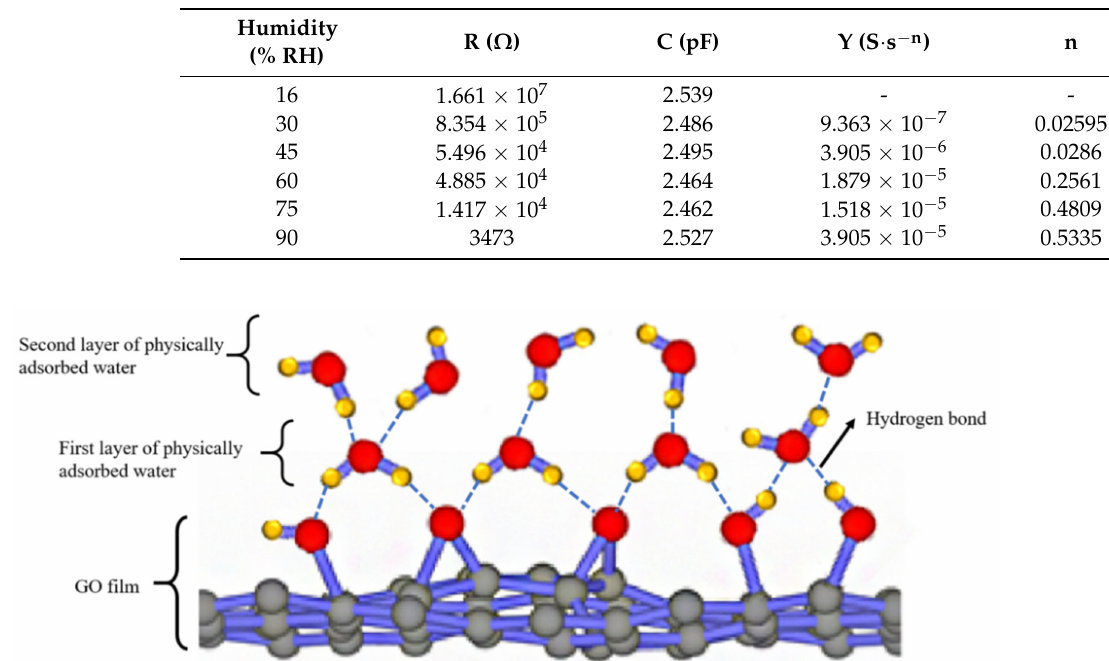
Table 2. Fitting parameters in electrical models under different humidity levels.